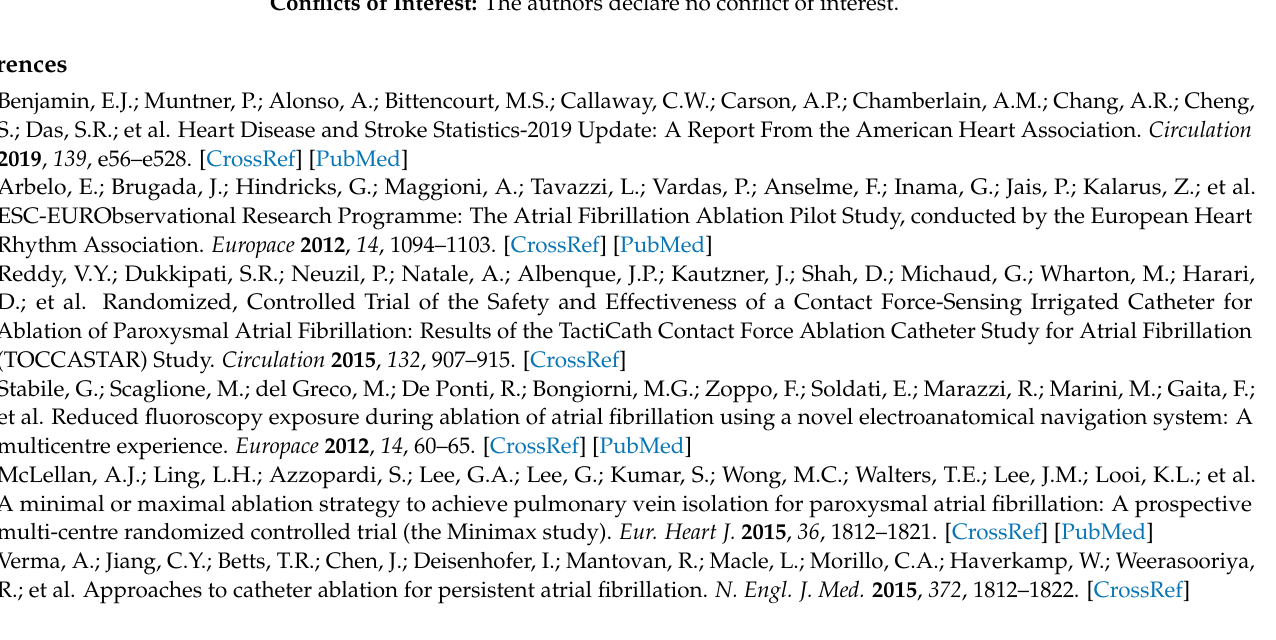
Comparison adjusted funnel plot; Figure S3: Network of anticoagulant comparisons for the composite of primary outcomes; Table S1: PRISMA network meta-analysis checklist; Table S2: PICOS format and detailed search code; Table S3: Efficacy and safety outcomes in the included studies; Table S4: Assessment of bias in the randomized clinical trials; Table S5: Sensitivity analysis; Table S6: Summary estimates for outcomes with each anticoagulant regimen from network